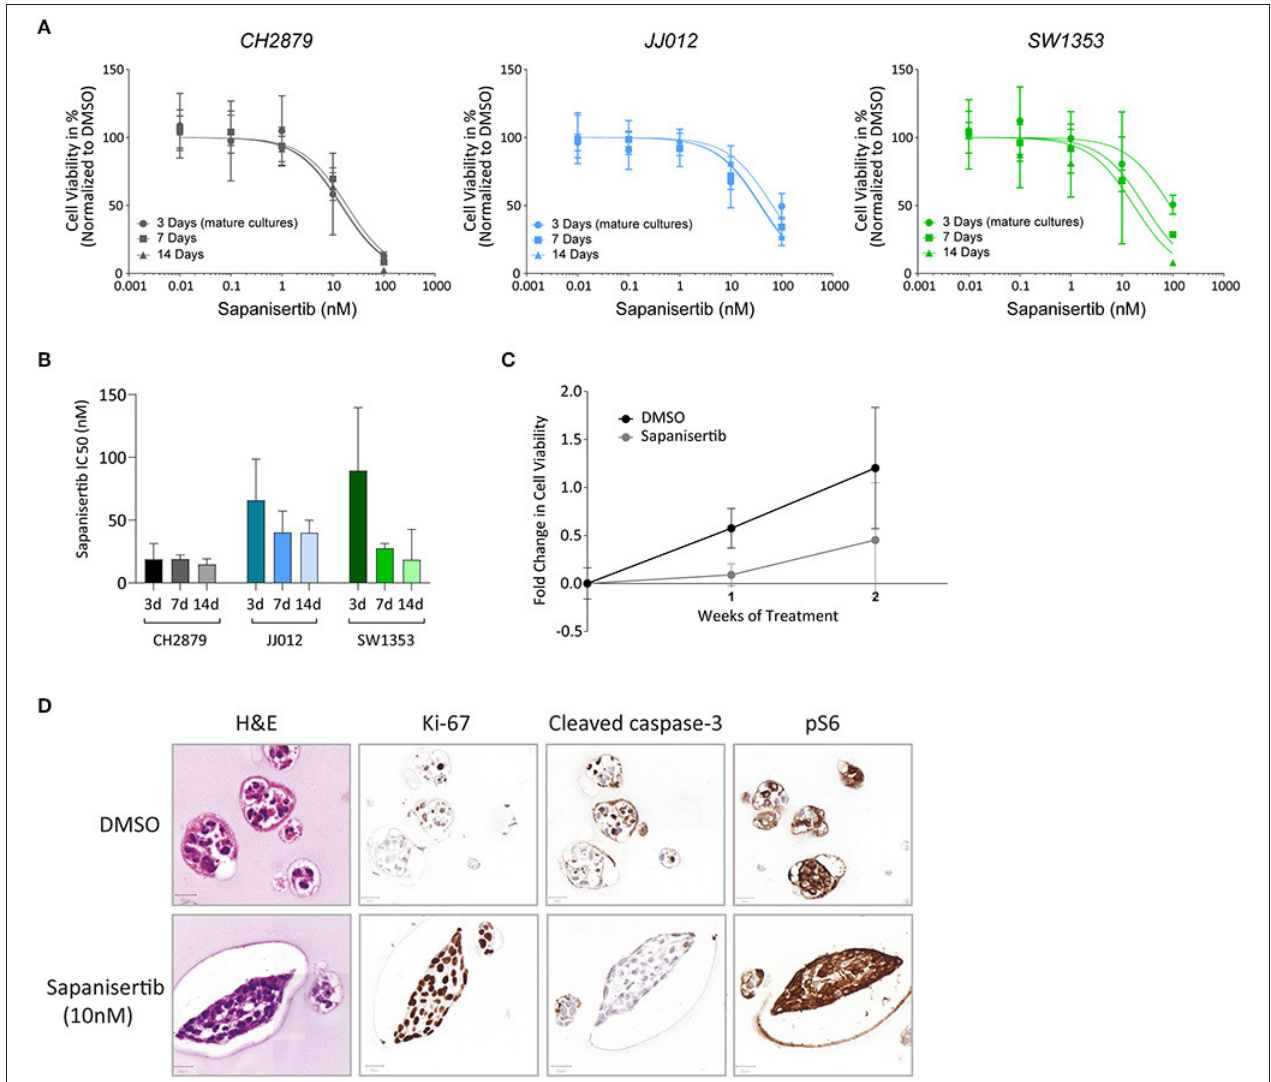
FIGURE 6 | Long-term treatment. (A) There is no significant difference in the viability of cell lines CH2879, JJ012 and SW1353 cultured in 3D if they receive 3 days of sapanisertib treatment as mature spheroids or treated over their growth period for 7 days or 14 days (doses at days one and eight). ( n ≥ 3) (B) There is no significant difference in the IC50 values between mature spheroid 3 day treatment or treatment over the growth period. (C) Growth rate of CH2879 spheroids treated with sapanisertib (10nM) increased over 2 weeks. ( n = 4) (D) No significant change in colony morphology or number was observed after 10nM treatment. Cells after 2 weeks of sapanisertib treatment were highly proliferative while apoptosis was absent and expression of pS6 was uninhibited, suggesting outgrowth of resistant colonies over time. Scale bar = 20 µ m, cell line = CH2879. All results were normalized to DMSO control as